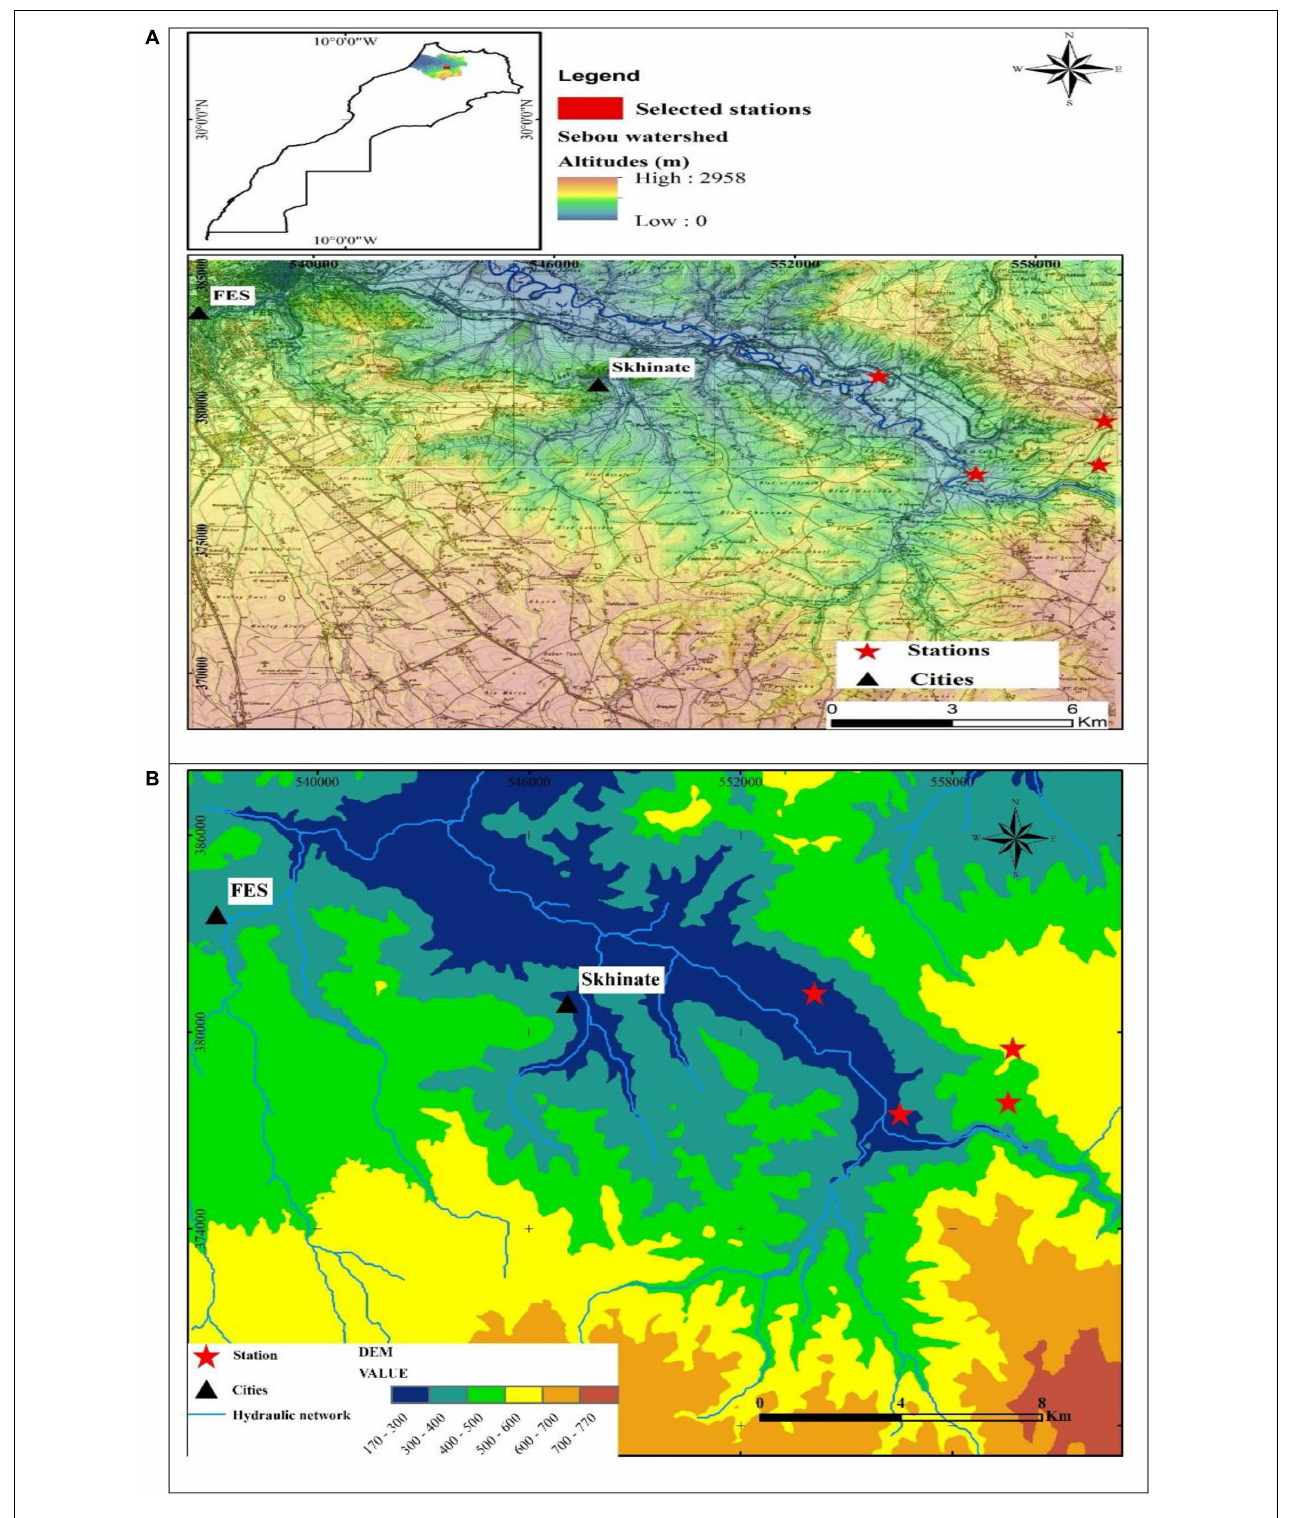
FIGURE 1 | Geological maps of the study stations (A1, A2, A3, and A4). (A) Locations of the study stations; (B) Digital Terrain Model (DTM).